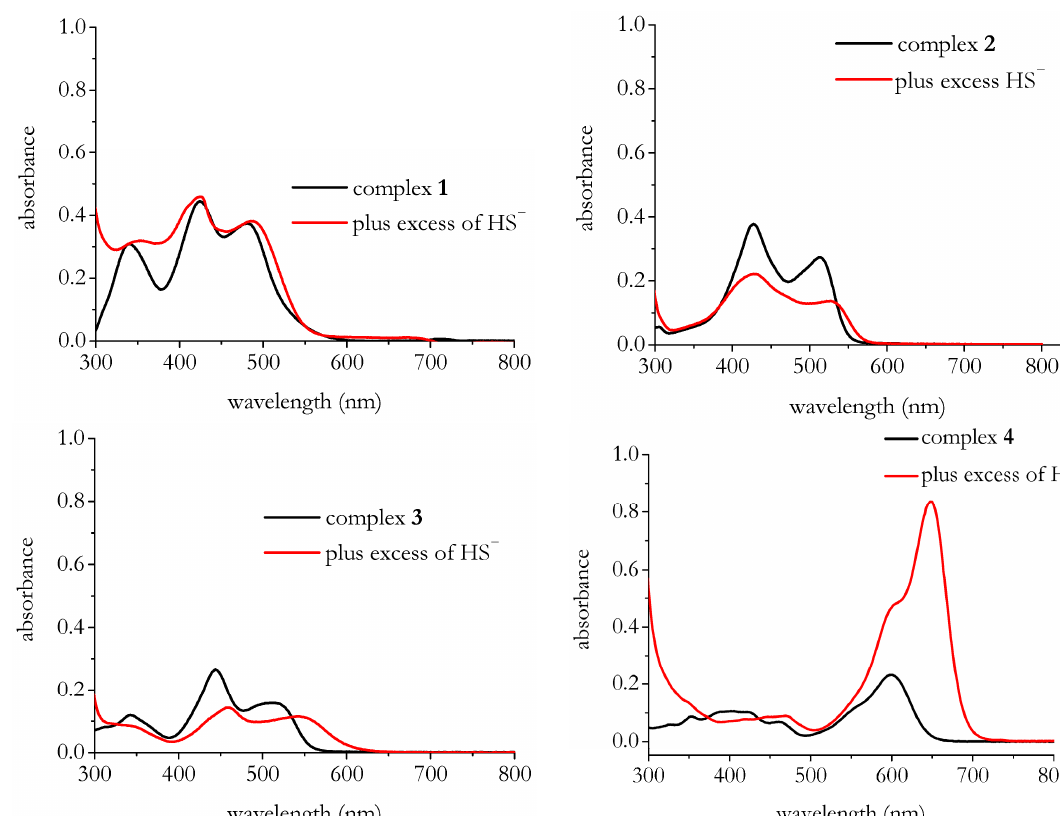
Figure 1. Electronic absorption spectra of complexes 1 – 4 with and without the addition of 50 μ M of NaSH. Spectra were recorded in DMSO at room temperature. [complexes] = 10 μ M.